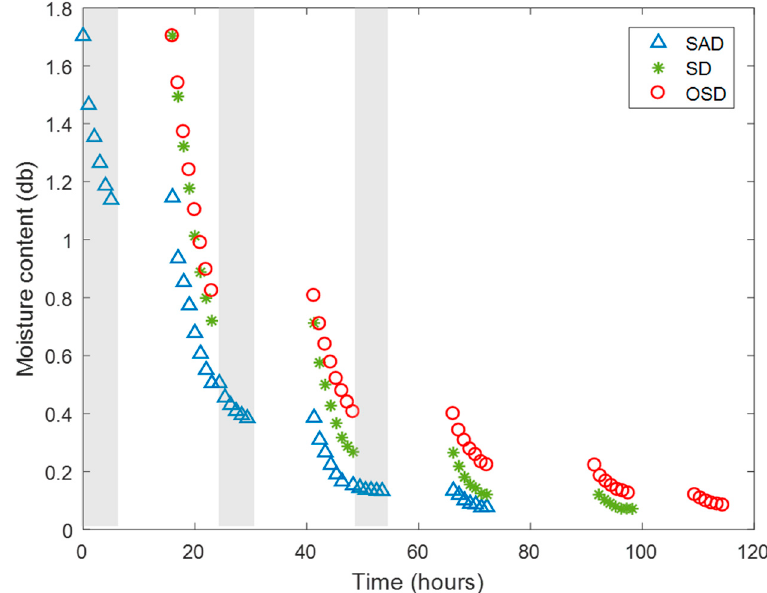
Figure 4. Average moisture content over all trays of yam particles (‘Dente’) for different drying methods, SAD, SD and OSD. The grey portions represent night drying.